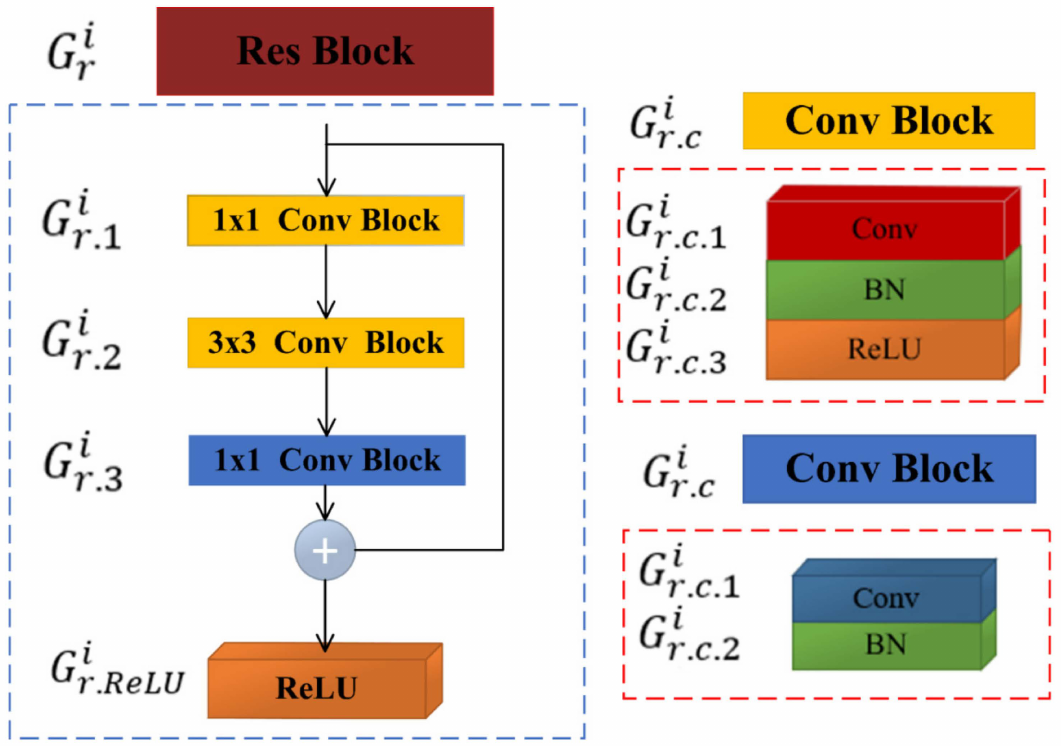
Figure 5. Bottleneck building